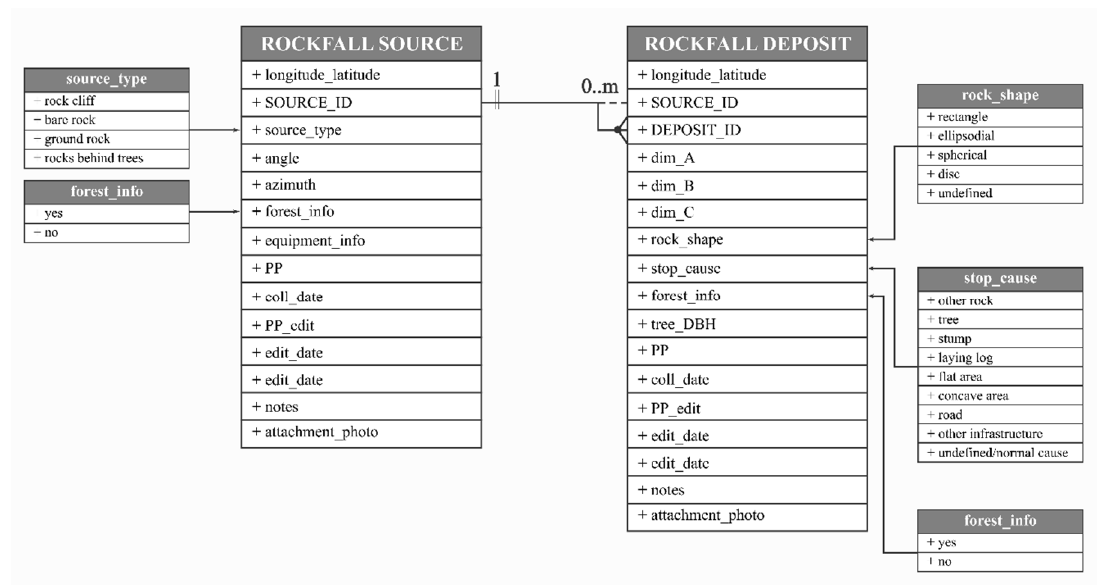
Figure 3. Model of the rockfall database showing a simplified construction of data within the mobile application. An individual rockfall source area is represented by a single record in the Rockfall_source table and can be related to multiple number of Rockfall_deposit records. Both tables show the possible attributes that can be collected by each feature. Categorical attributes source_type, forest_info, rock_shape, and stop_cause can only be chosen based on the pre-defined classes from the drop-down menus.